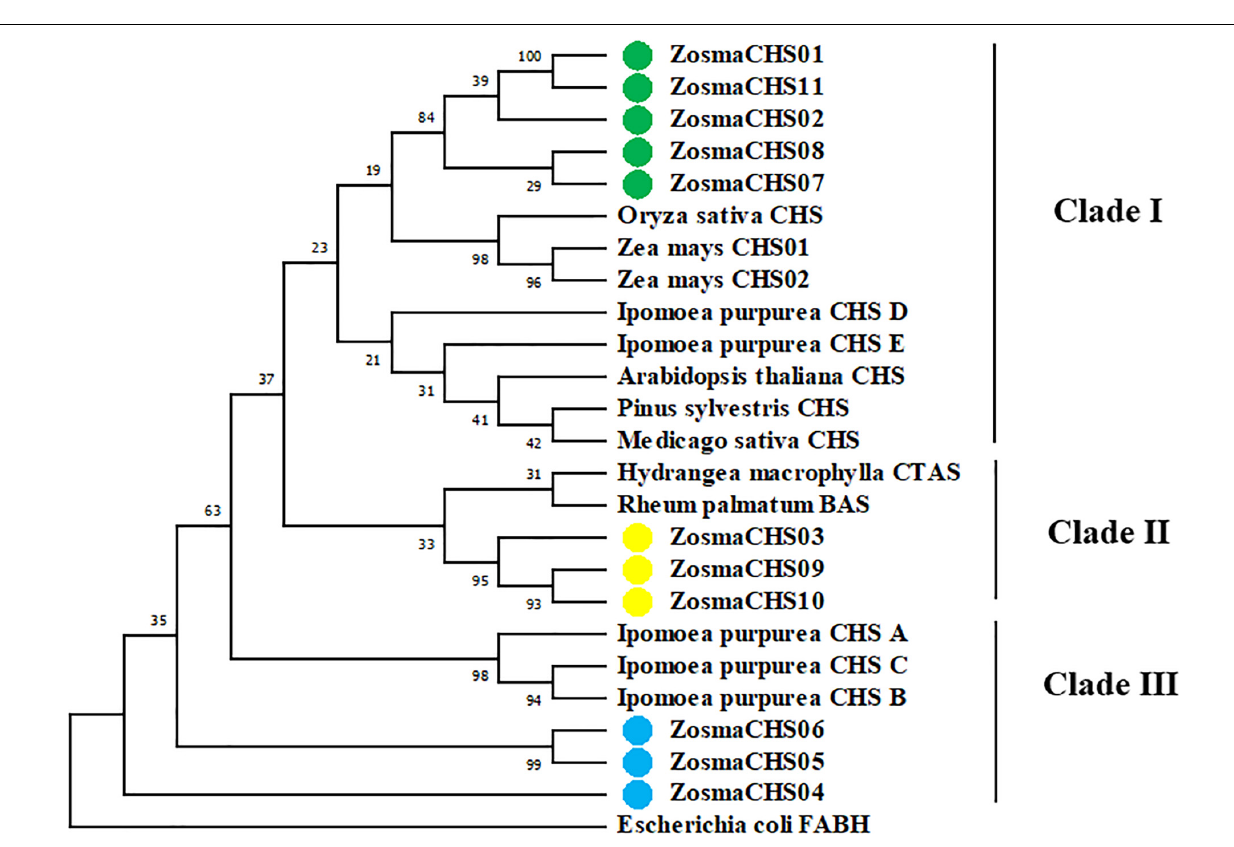
into three groups. TCT-motif, GA-motif, and MRE related to light response and TCA-element related to salicylic acid responsiveness were in group I ( ZosmaCHS05 - 07 and 09 ) and II ( ZosmaCHS02 , 04 and 10 ), indicating that the genes could be regulated by light stress and the salicylic acid